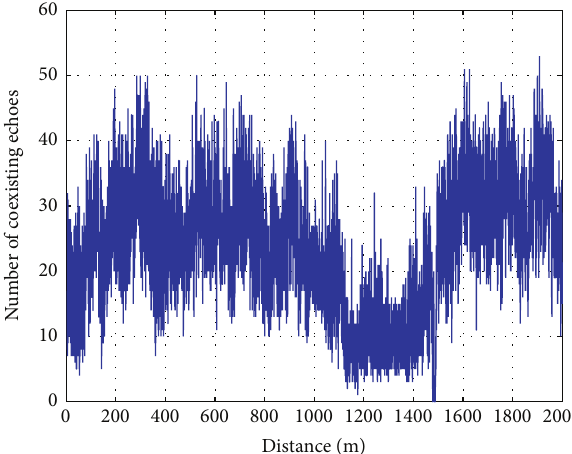
Figure 19: Number of coexisting echoes during a drive through the city center of